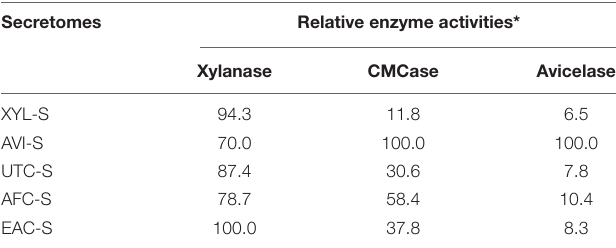
TABLE 3 | Secretome enzyme activity assay